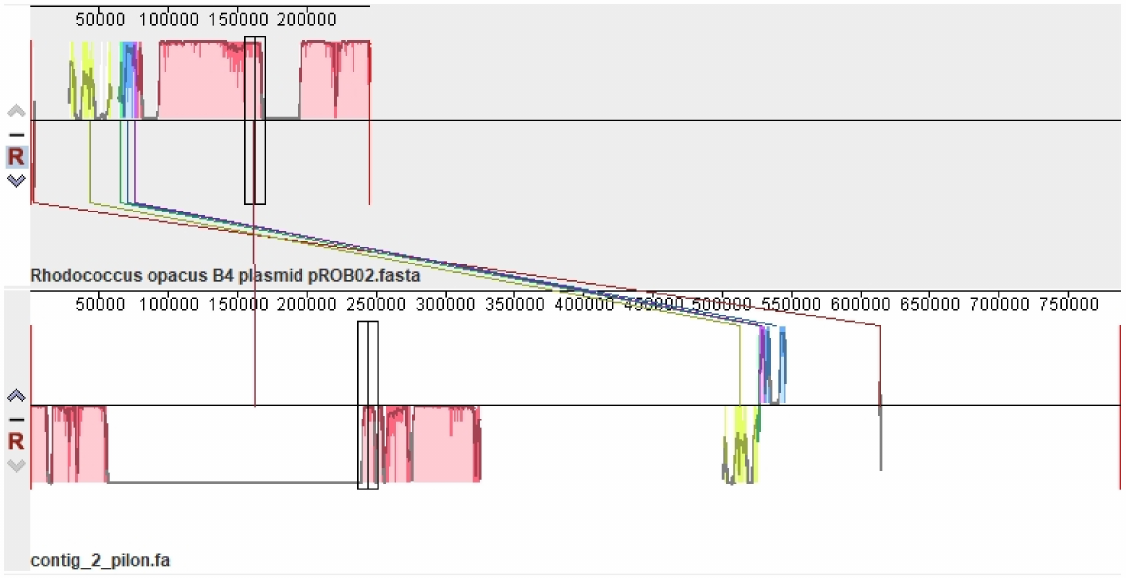
Figure 2. Mauve visualization of locally collinear blocks identified between pLPS8 of R. opacus S8 and its closest relative pROB02 of R. opacus B4. Vertical bars mark interchromosomal